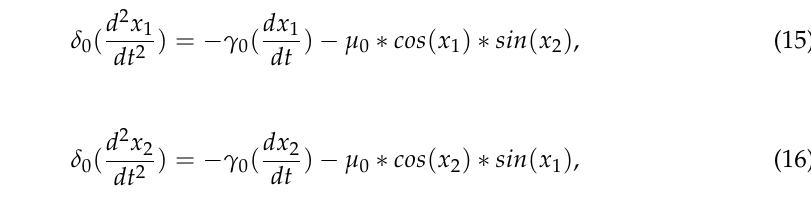
Table 2. Part Two: Initial Conditions of the Objective functions. Type of